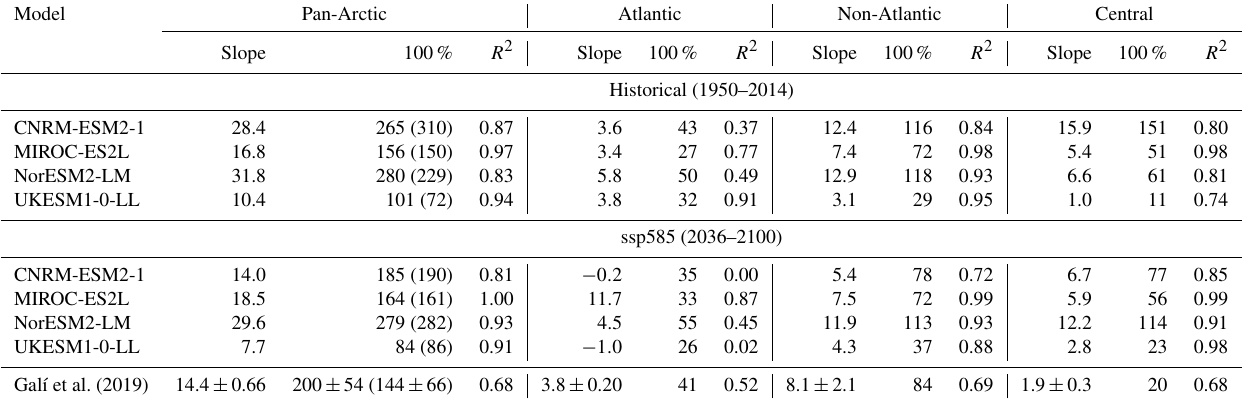
Table 9. Metrics of the scatter plots of Fig. 15, DMS emissions vs. ice-free extent: slopes of the regression lines (GgS per 10% of free-water extent), projected DMS emissions at 100% free water (GgSyr − 1 ), and determination coefficients. Metrics are shown for the pan-Arctic (with sums of the individual regions in parentheses), Atlantic and non-Atlantic sectors (excluding the central basin), and the central basin as in Galí et al. (2019), for the four models. Values from Galí et al. (2019) are also presented. Model Pan-Arctic